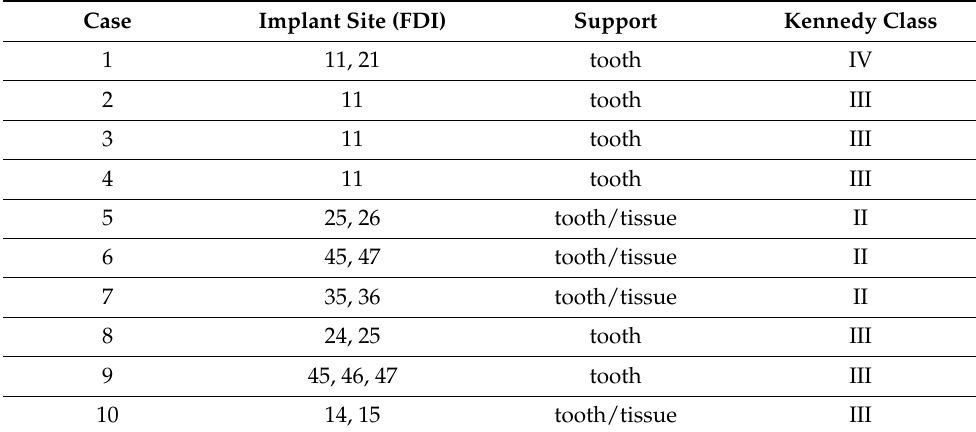
Table 1. Implant case details.